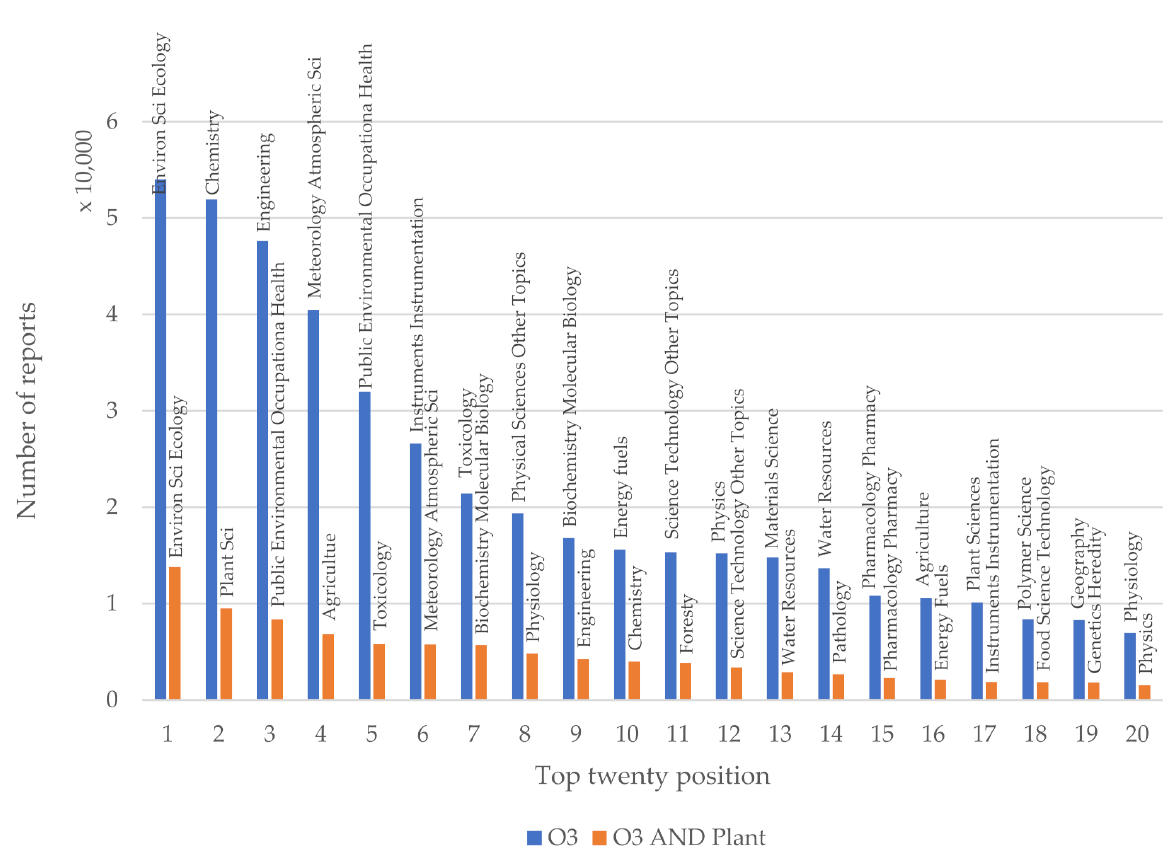
Figure 2. Distribution (number of reports) of worldwide research on Ozone (O 3 ) and O 3 and plant by subject area, as classified by